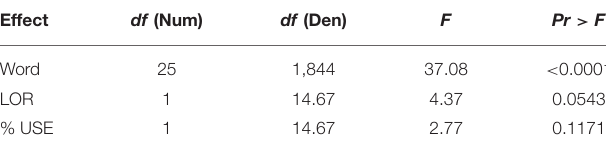
TABLE 7 | Type III tests of fixed effects